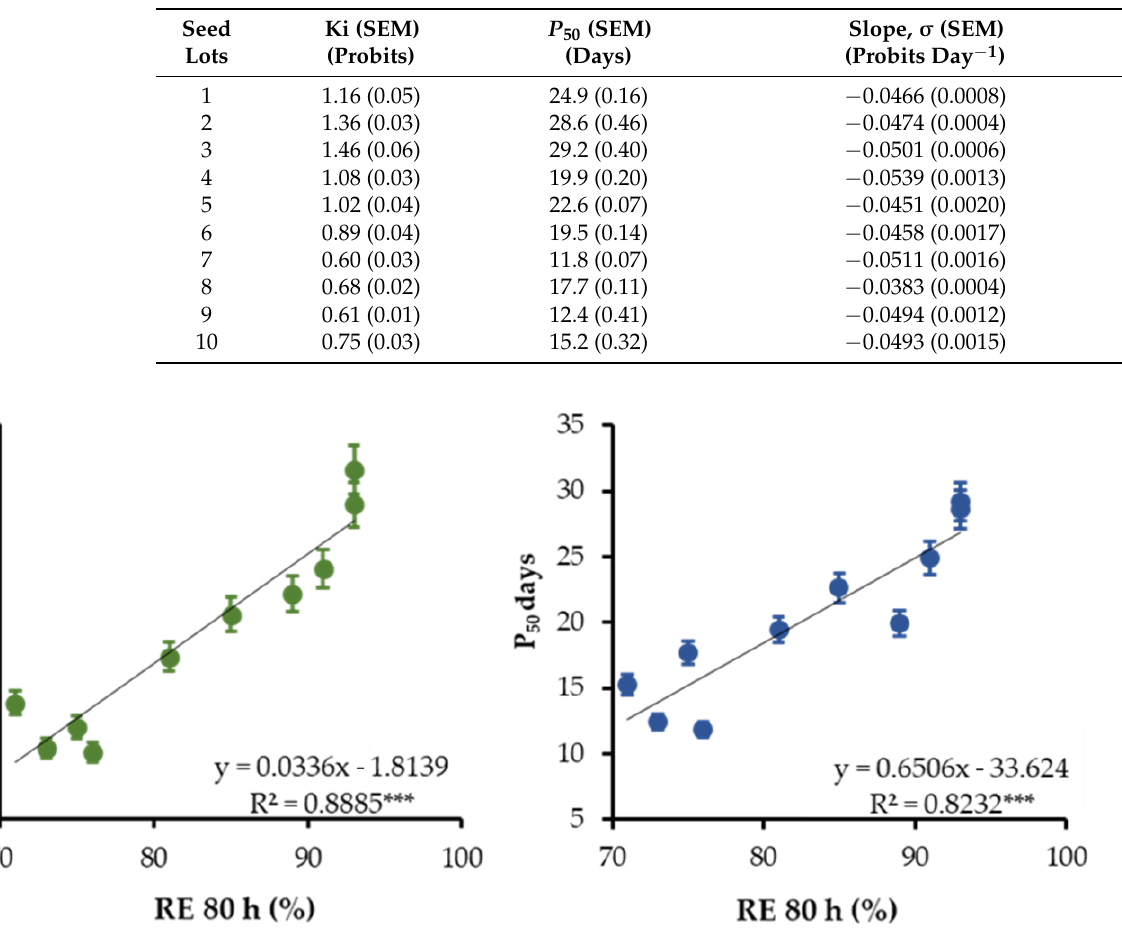
Table 2. Probit model parameters (standard error of the mean) for seed lots of ten onion ( Allium cepa L.) seed lots stored aged with NaCl at 35 ± 2 ◦ C. Seed Ki (SEM) Lots